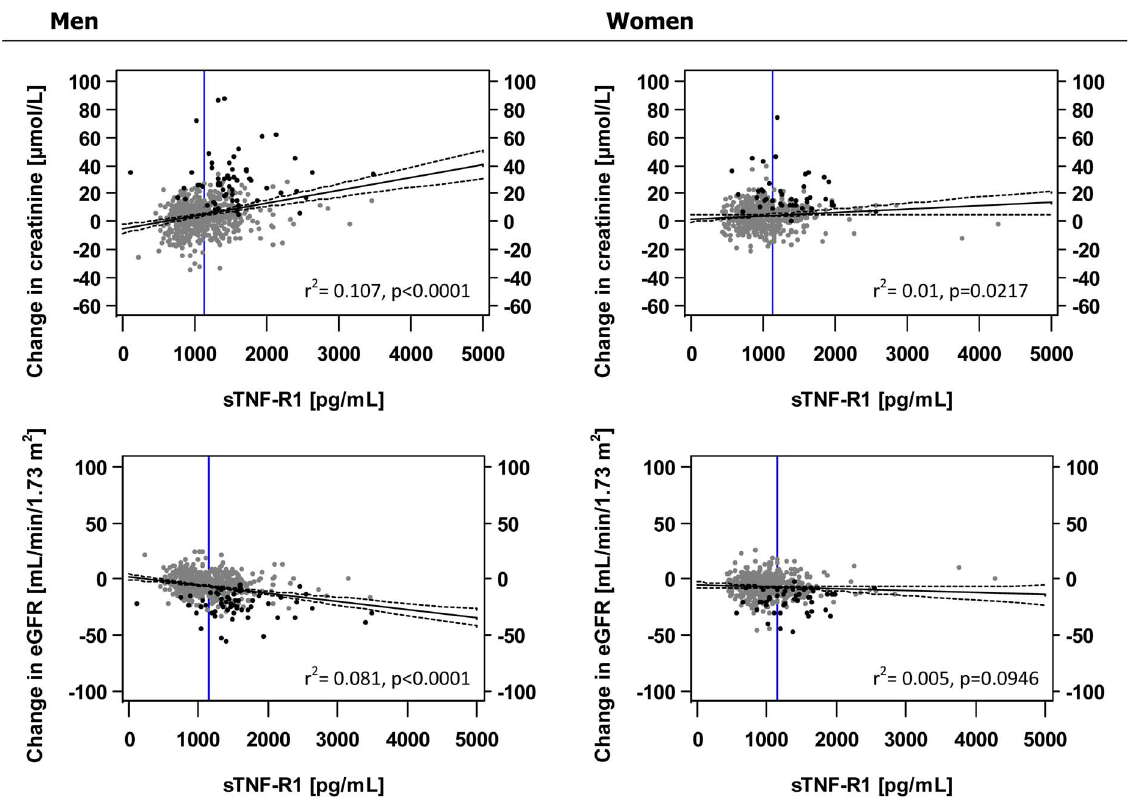
Figure 1. sTNF-R1 and change in eGFR/creatinine from baseline to follow-up. Black line: regression line with corresponding 95% (dashed line); vertical blue line: optimal cut off; black dots: subjects with eGFR , 60 mL/min/1.73 m 2 at follow-up; grey dots: subjects with eGFR . 60 mil/min at follow-up. Abbreviations: sTNF-R1: Soluble tumour necrosis factor- a receptor 1, eGFR: estimated glomerular filtration rate.